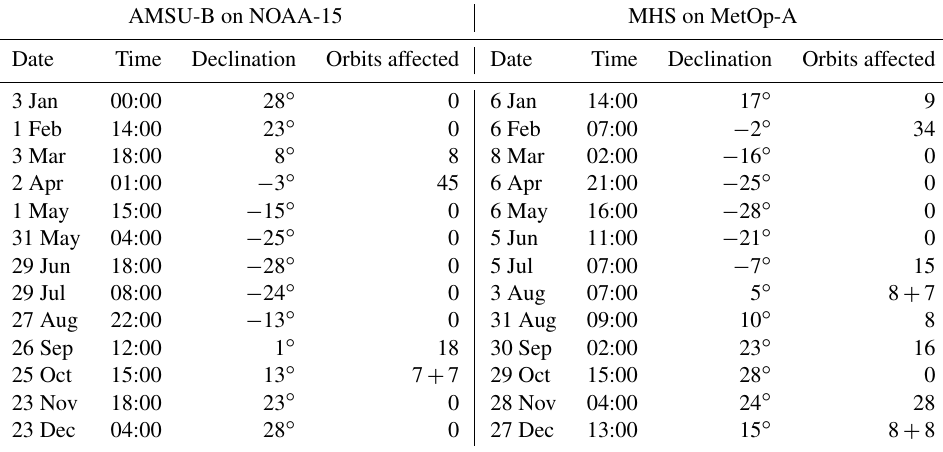
Table 2. Date and time of the closest approaches of the Moon to the deep-space view of two microwave sounders in the year 2007. The third and seventh column give the position of the DSV direction relative to the celestial equator at these moments in time, and the fourth and eighth column give the number of orbits which were contaminated by the Moon. Intrusion events affect several orbits in a row, sometimes in groups of two with 1 or 2 days in between. Their durations depend on the relative movements of the DSV direction and the Moon. Due to a few simplifications in the calculations, the values in this table are only accurate to 1 ◦ and 1h. AMSU-B on NOAA-15 MHS on